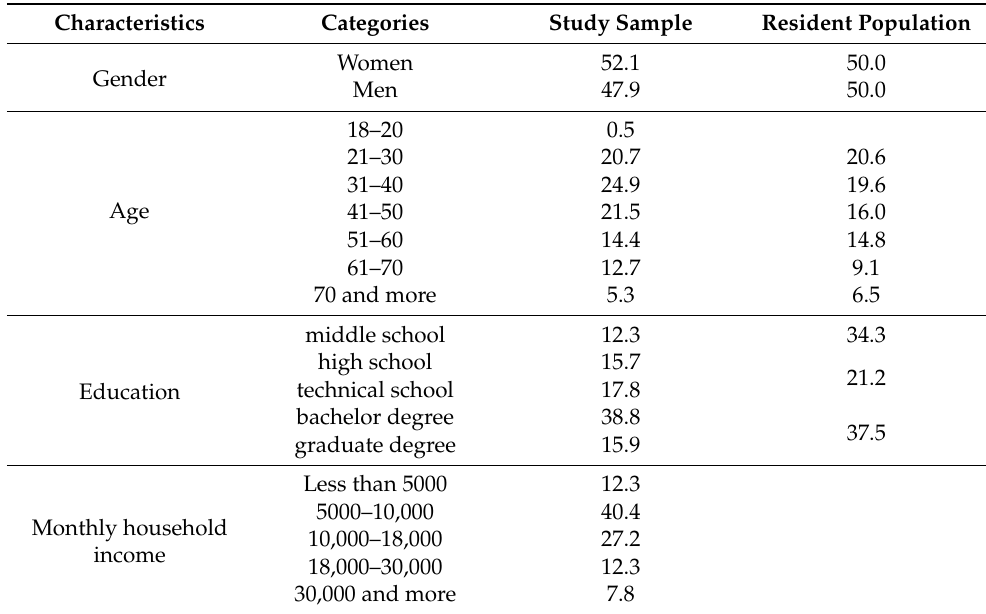
Table A1. A comparison of the sample with the resident population in Beijing